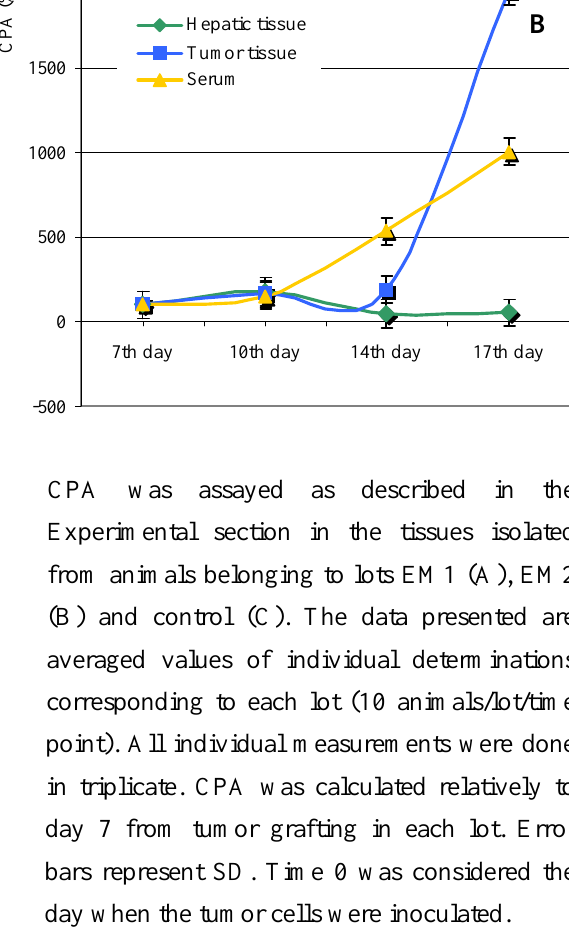
CPA was assayed as described in the Experimental section in the tissues isolated from animals belonging to lots EM1 (A), EM2 (B) and control (C). The data presented are averaged values of individual determinations corresponding to each lot (10 animals/lot/time point). All individual measurements were done in triplicate. CPA was calculated relatively to day 7 from tumor grafting in each lot. Error bars represent SD. Time 0 was considered the day when the tumor cells were